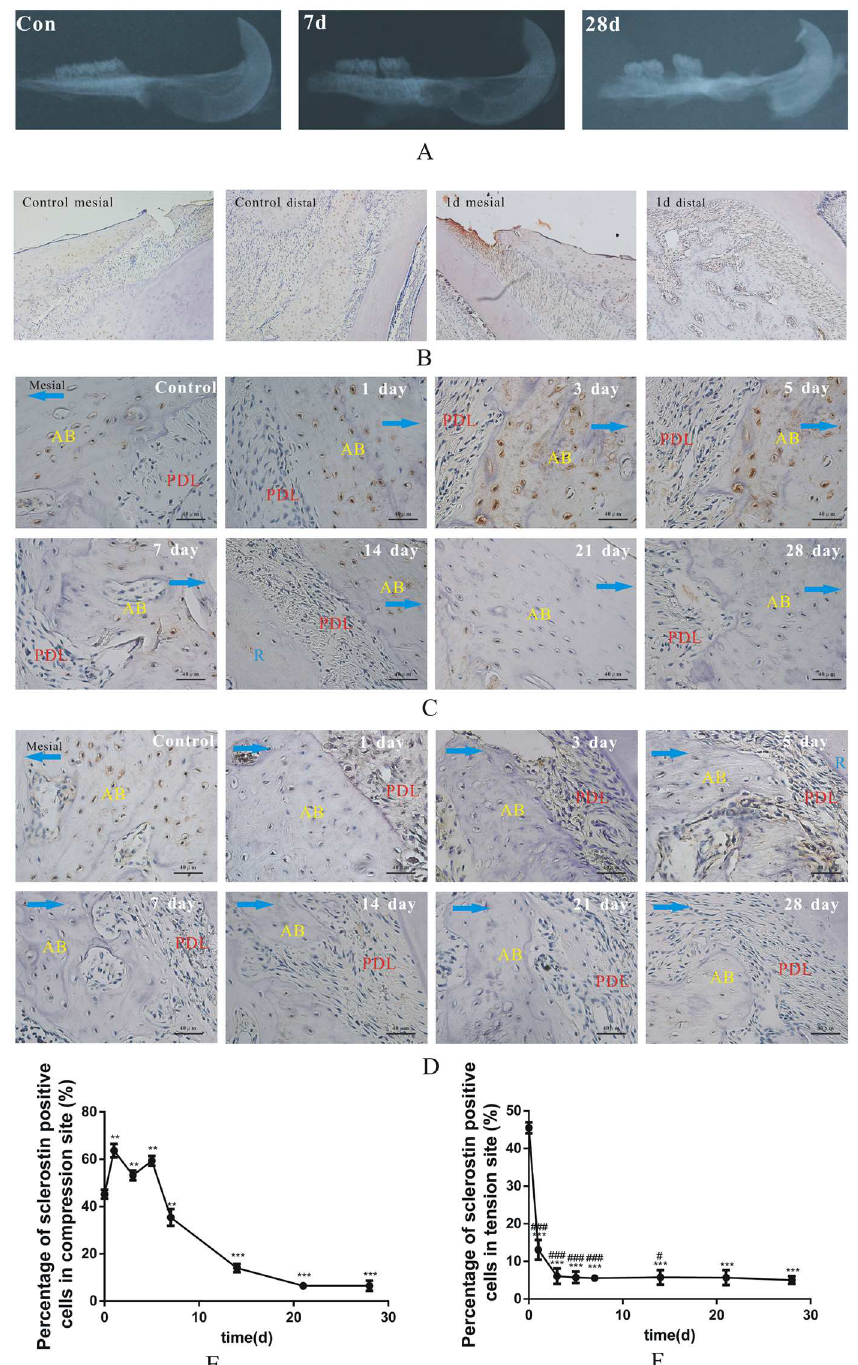
Fig 1. Expression of sclerostin was different between the compression and tension sites during tooth movement. (A) X-ray images showed the mesial movement of the first molars at 0 d, 7 d and 28 d. (C) IHC of sclerostinat the compressionsites. Sclerostin maintainedhigh expression at 1d, 3d, 5d and 7d and gradually diminished until 28 d. Alveolar bone(AB), PDL (periodontal ligament), and R (root). The blue arrow indicated the mesial side in control group and the directionof tooth movementin experimentgroups. (D) IHC of sclerostinat the tension site. Sclerostin immediately decreased and was continuallymaintainedat the low level during 28 days of tooth movement. AB (alveolar bone), PDL (periodontal ligament),R (root). (E) Semi- quantification of IHC of sclerostinat the compression sites. n = 3, ** p < 0.01vs control, *** p < 0.001vs